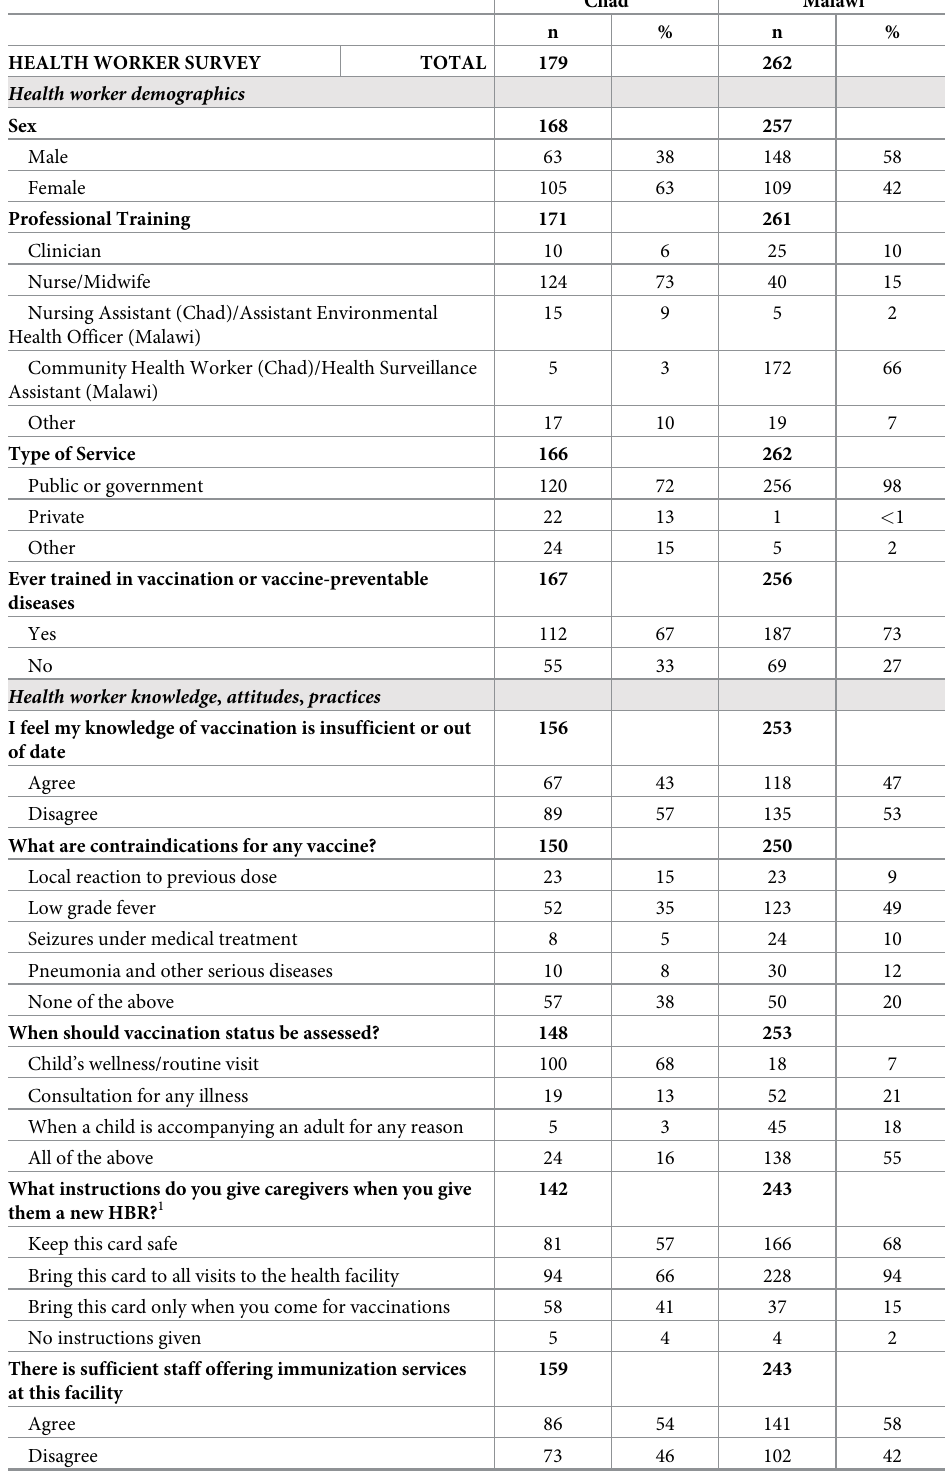
Table 2. Characteristics and knowledge, attitudes, and practices of surveyed health workers: Chad and Malawi,